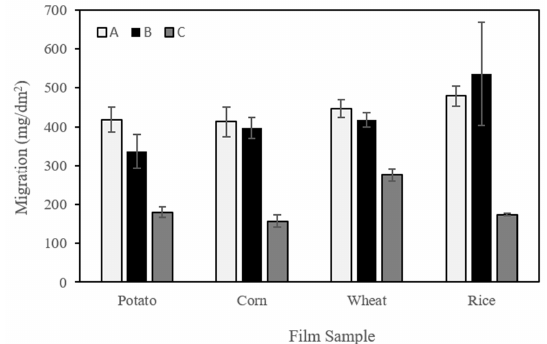
Figure 3. Overall migration values into different food simulants. ( A ) Ethanol (10% v / v ), ( B ) acetic acid (3% w / v ), and ( C ) isooctane. (3% w / v ), and ( C )